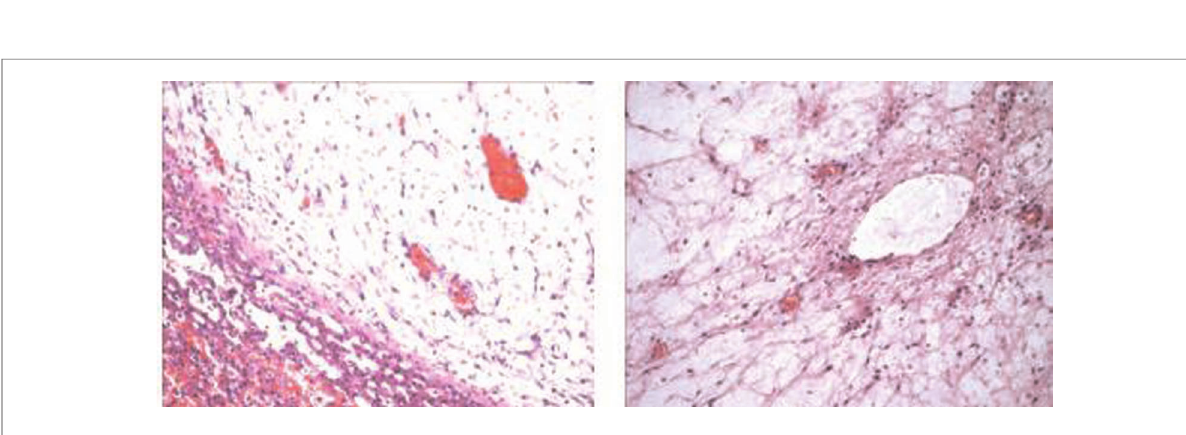
FIGURE 3 Nonmalignant proliferation of hepatocytes and fi broblasts could be seen in the edematous collagen